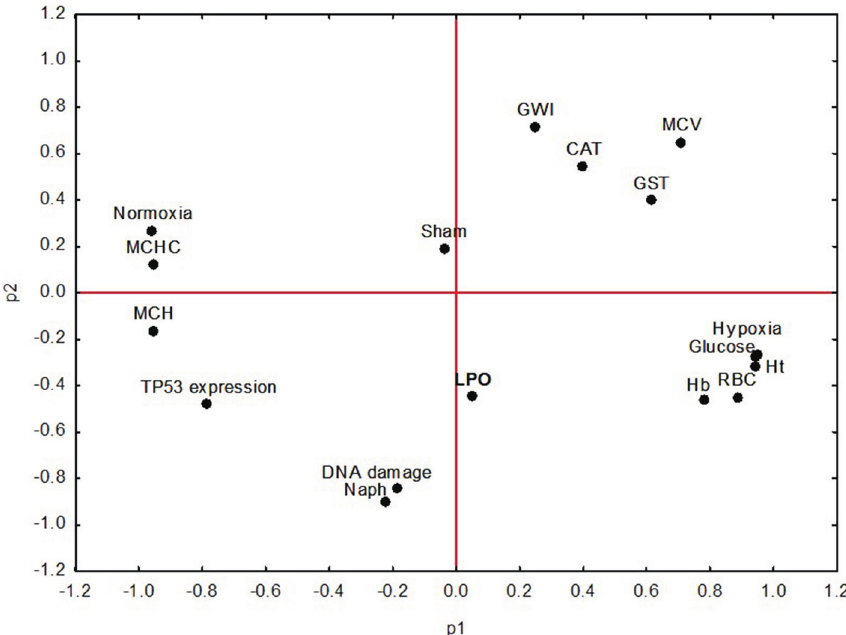
Figure6 -BiplotrepresentingthedistributionofPCAvaluesforthevariablesanalyzedin C.macropomum inthethreeexperimentalgroups:GroupWith- outInjection(GWI);Groupwithcornoilinjection(Sham);andGroupwithnaphthaleneinjection(Naph)after96hnormoxiaexposurefollowedby6hof hypoxia. All groups are compared and variation among variables is explained by p1 = 50.0% and p2 =